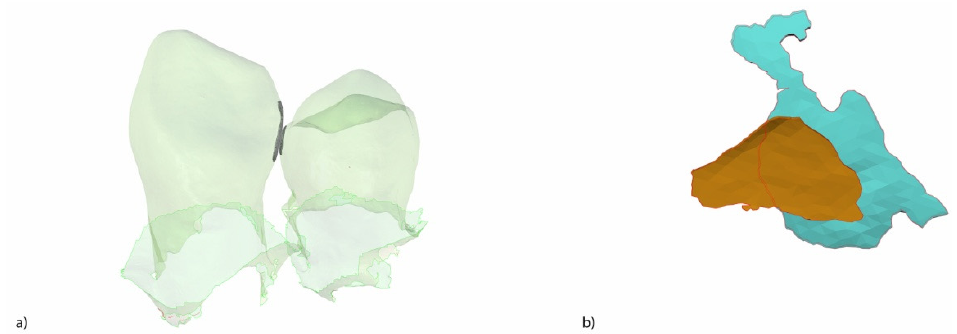
Figure 5. ( a ) Interproximal view of the individually segmented and aligned preoperative and postoperative interproximal enamel reduction STL digital files (teeth 3.3 and 3.4) and the ( b ) digital mesh of the enamel removed in the distal interproximal surface of tooth 3.3 (blue) and digital mesh of the enamel removed in the mesial interproximal surface of tooth 3.4 (brown).